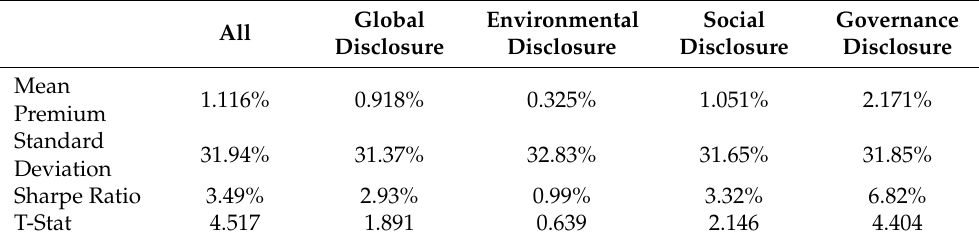
Table 3. Mean premiums, standard deviations, Sharpe ratios and